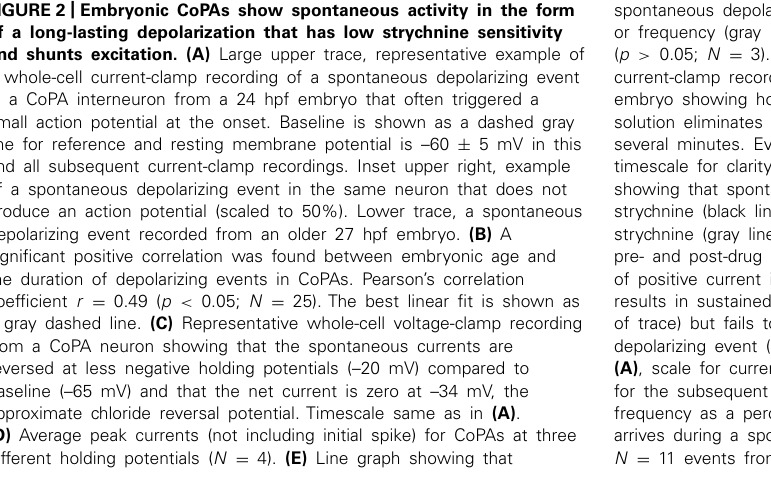
spontaneous depolarizing events do not change in duration (black lines) or frequency (gray lines) following addition of 1 μ M strychnine ( p > 0.05; N = 3). (F) Middle trace, a four-minute excerpt of a current-clamp recording of spontaneous CoPA activity in a 27.5 hpf embryo showing how 10 μ M strychnine washing into the extracellular solution eliminates all spontaneous depolarizations over the course of several minutes. Events in dashed boxes i–iii are shown on an expanded timescale for clarity. Scale for i–iii same as in (A) . (G) Line graph showing that spontaneous depolarizing events are maintained in 1 μ M strychnine (black lines; p > 0.05; N = 3) but completely lost in 10 μ M strychnine (gray lines; ∗∗∗ p < 0.001; Student’s t -test for each neuron pre- and post-drug application; N = 3). (H) An example of an injection of positive current in a CoPA from a 27 hpf embryo that normally results in sustained action potential firing at baseline (beginning and end of trace) but fails to elicit any action potentials during a spontaneous depolarizing event (middle of trace). Scale for upper trace same as in (A) , scale for current injection is shown. The measure of latency used for the subsequent is indicated. (I) Scatterplot of the reduction in firing frequency as a percentage of baseline when a positive current injection arrives during a spontaneous depolarizing event at various delays. N = 11 events from five